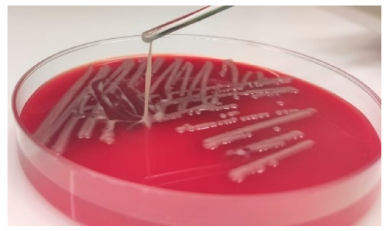
Figure 1. Hypermucoviscous phenotype of the hvKp strain 18-0005. The hypermucoviscous pheno- type is represented by a positive “string test”. Table 1. Antibiotic susceptibilities of hypervirulent K. pneumoniae strain 18-0005. Antibiotic MIC